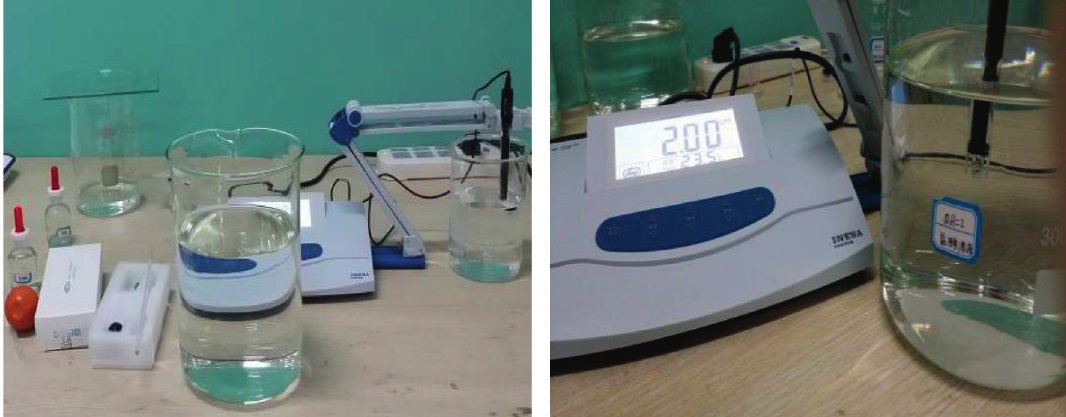
Figure 2: Preparation of acidic solutions.